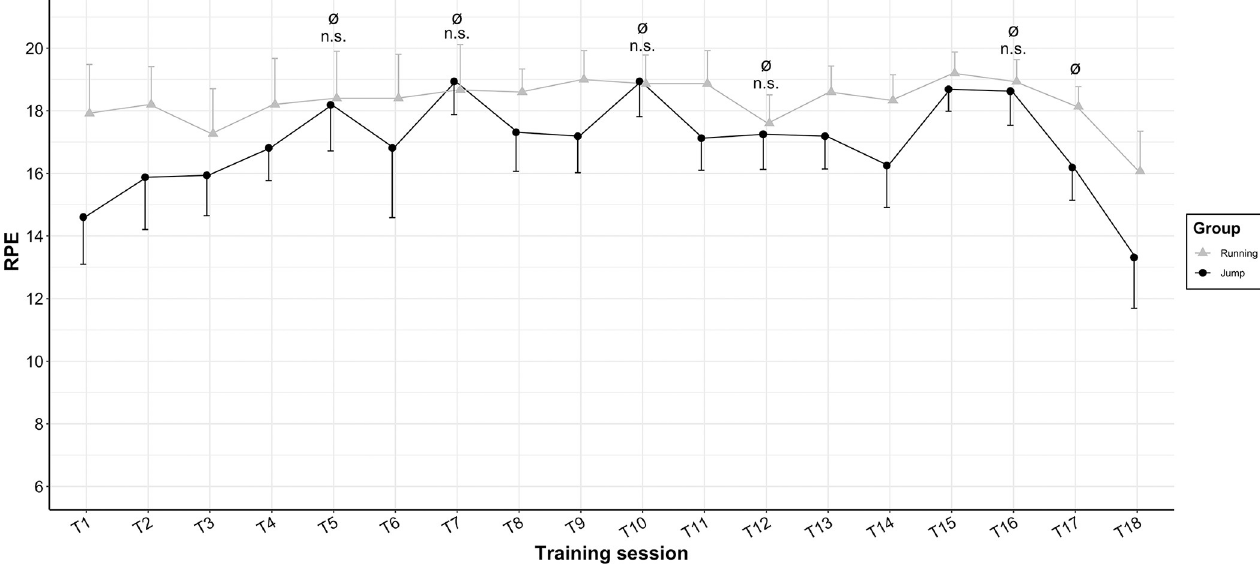
Fig 4. Average rated perceived exertion (RPE, mean and SD) for the two training groups during the 18 training sessions. Data for the jump training group is shown in black, and data for the running training group is in grey. Ø = on top of the training session denotes the jump training sessions with continuous jumps. n.s. = denotes training sessions with no significant differences in RPE between JT and RT (evaluated with independent-samples t- tests).